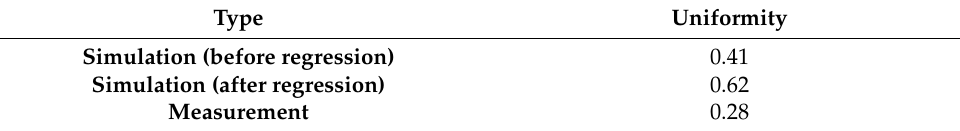
Figure 24. ( a ) Illuminated area emitted by a flat mirror; and ( b ) illuminated area emitted by a freeform reflector. Table 2. Uniformity comparison of the simulated and measured results.